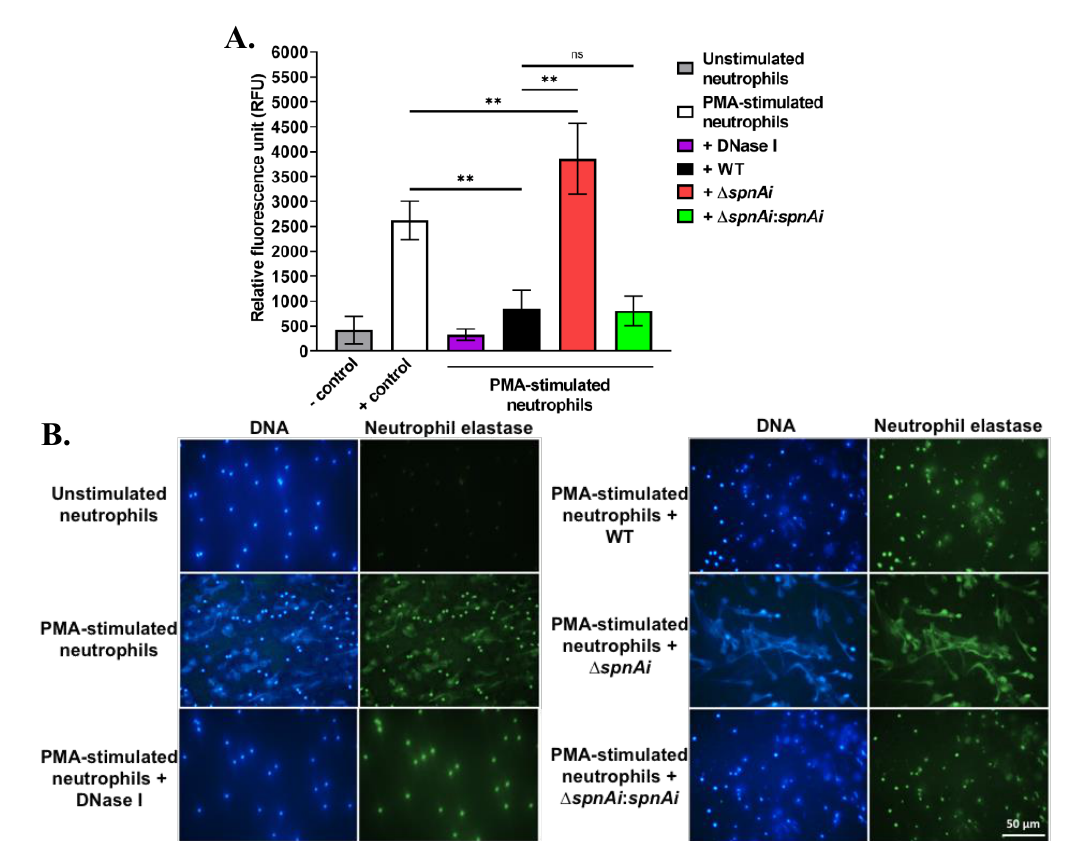
Figure 2. Release and destruction of neutrophil extracellular traps (NETs) by various S. iniae strains. ( A ) The extracellular DNA stain Sytox Orange was used to quantify the NETs and is presented as relative fluorescence units (RFU). NETs were degraded in the presence of WT S. iniae and DNase I (positive control), but not in the presence of the spnAi deletion mutant. Complementation of the mutant strain with a functional spnAi gene restored the NET-degrading ability of the mutant strain. Error bars show the standard deviation of two experiments performed in triplicate. **, p < 0.01; ns, not significant (as determined by an unpaired two-tailed t -test). ( B ) Immunofluorescence microscopy of zebrafish neutrophils. DAPI stain (blue) indicates both the neutrophil nuclei and released NETs. A cross-reactive human antibody against zebrafish neutrophil elastase, a bactericidal enzyme associated with NETs, was used to label the released NETs (green). Activation of unstimulated neutrophils (top left) results in NET release (middle left), which could be degraded by adding DNase I (bottom left). Addition of WT S. iniae also led to NETs destruction (top right), which was abrogated in the spnAi deletion mutant (middle right) and restored by complementing the deletion mutant with the spnAi gene (bottom